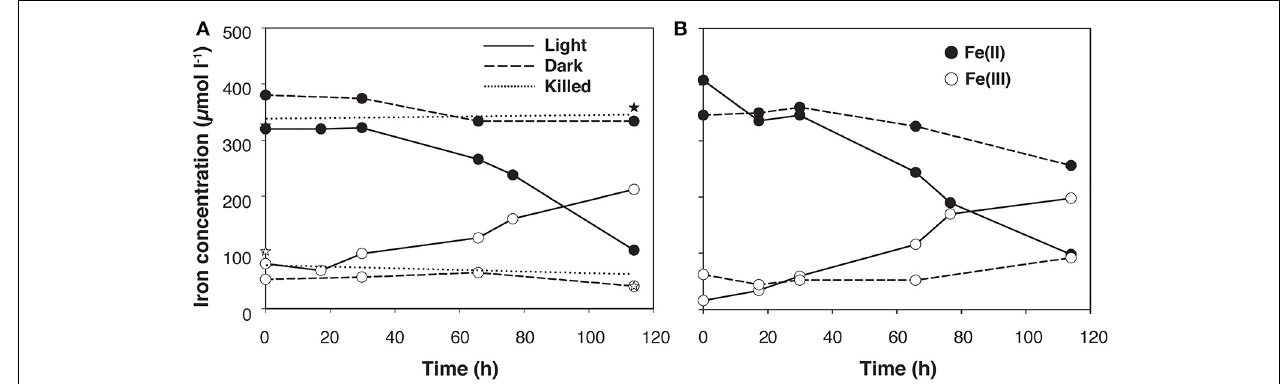
FIGURE 5 | Light-dependent iron-oxidation by the natural microbiota from the anoxic part of the Lake La Cruz chemocline at 11.8m depth. Anoxic laboratory ( ex situ ) incubation experiment (11/Feb/2008) (A) without DCMU addition, where oxygenic photosynthesis is active and abiotic Fe(II) oxidation with O 2 may occur; and (B) Fe(II) evolution under anoxic conditions